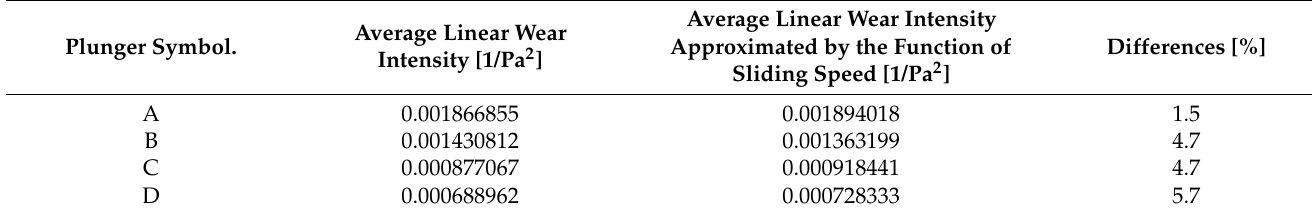
Table 15. The linear wear intensity values for the plunger fins.